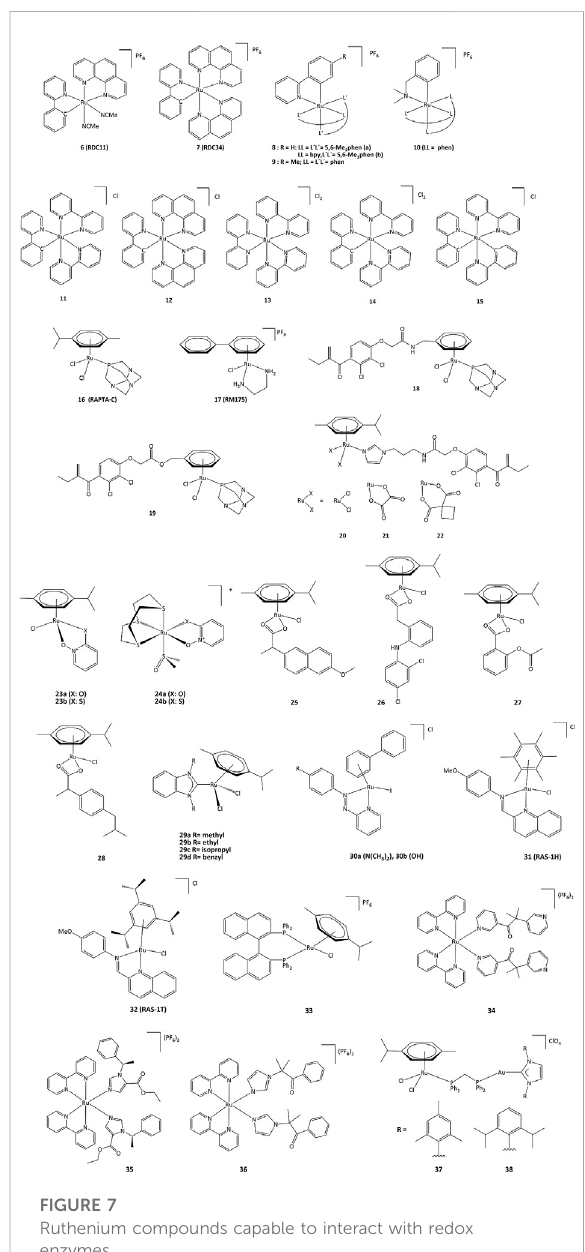
FIGURE 7 Ruthenium compounds capable to interact with redox